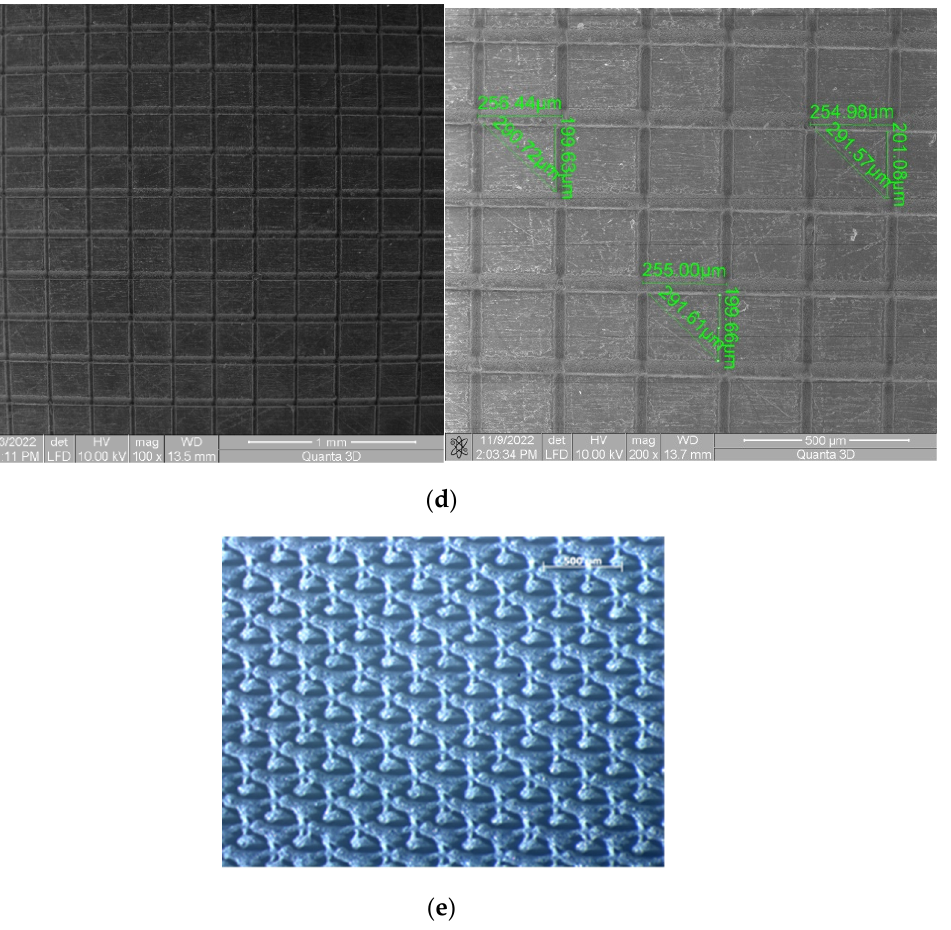
Figure 3. The geometries and number of passes: ( a ) hexagonal 2X; ( b ) hexagonal 4x; ( c ) square 2X; ( d ) square 4X; ( e ) triangle 4 passes.